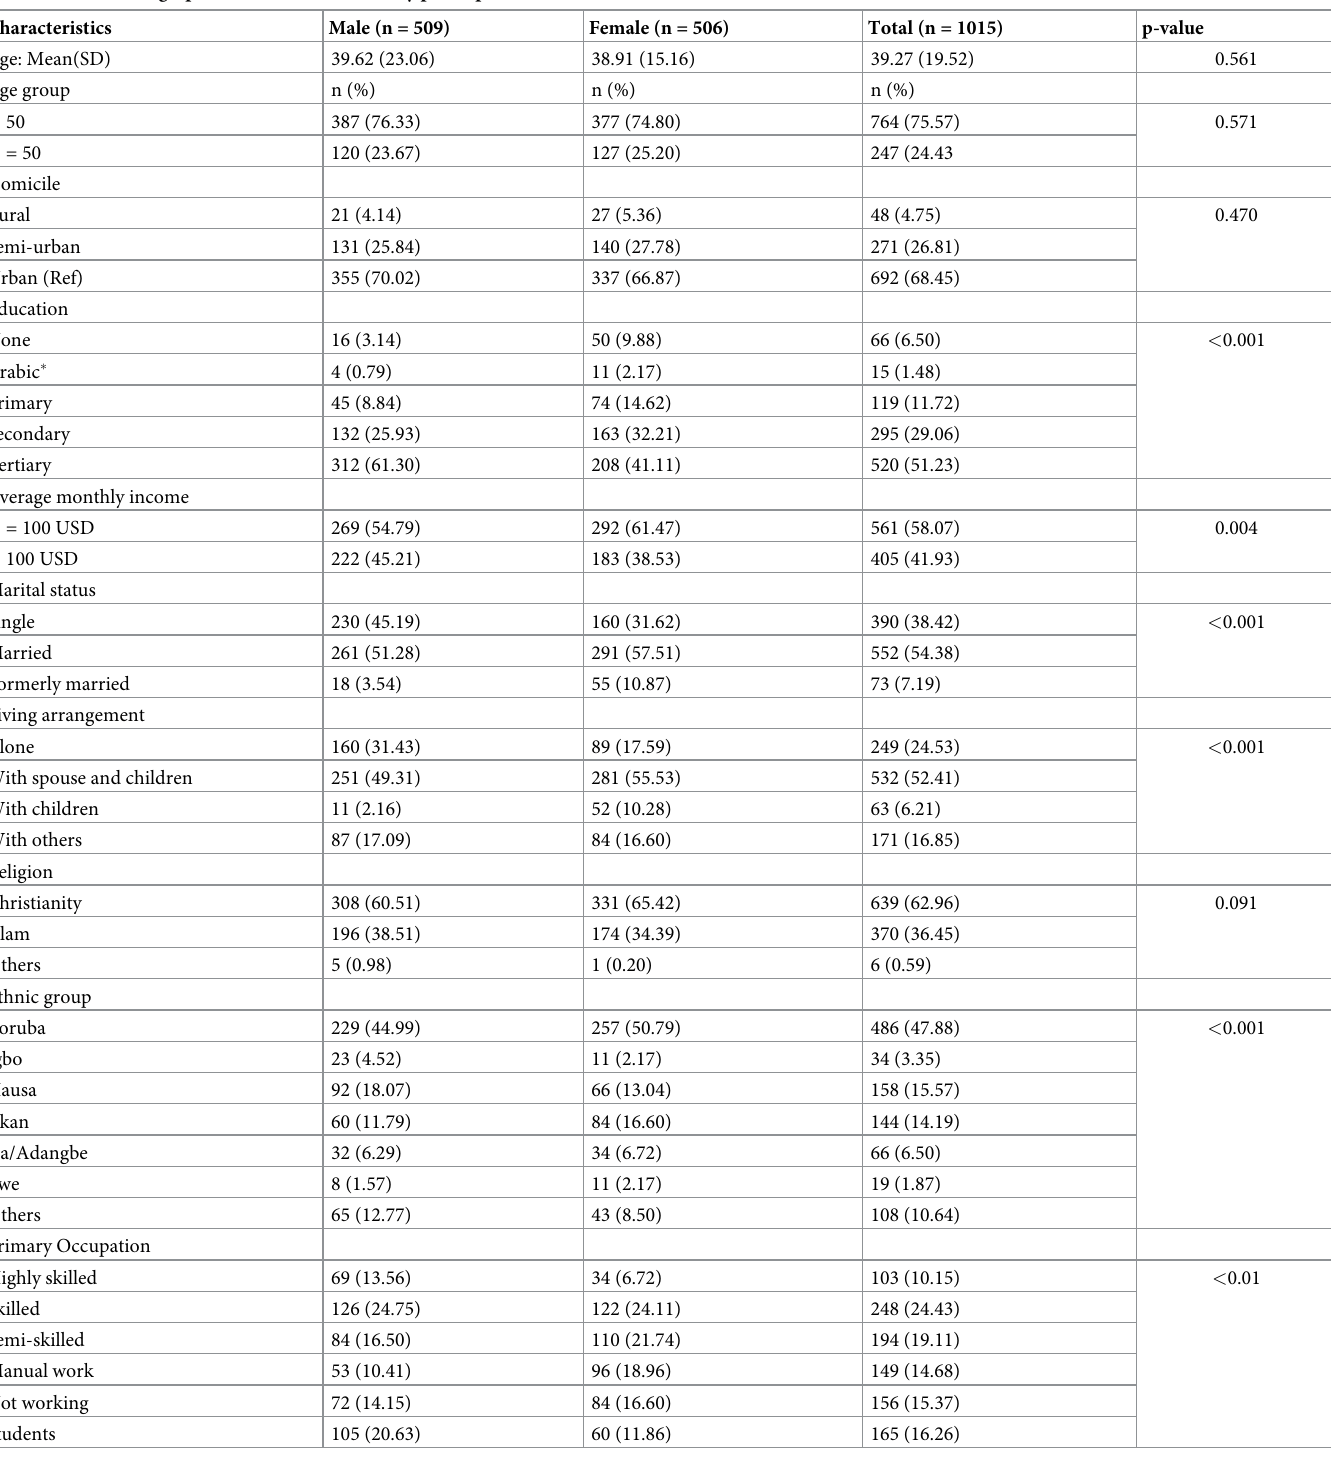
Table 1. Socio-demographic characteristics of study participants.